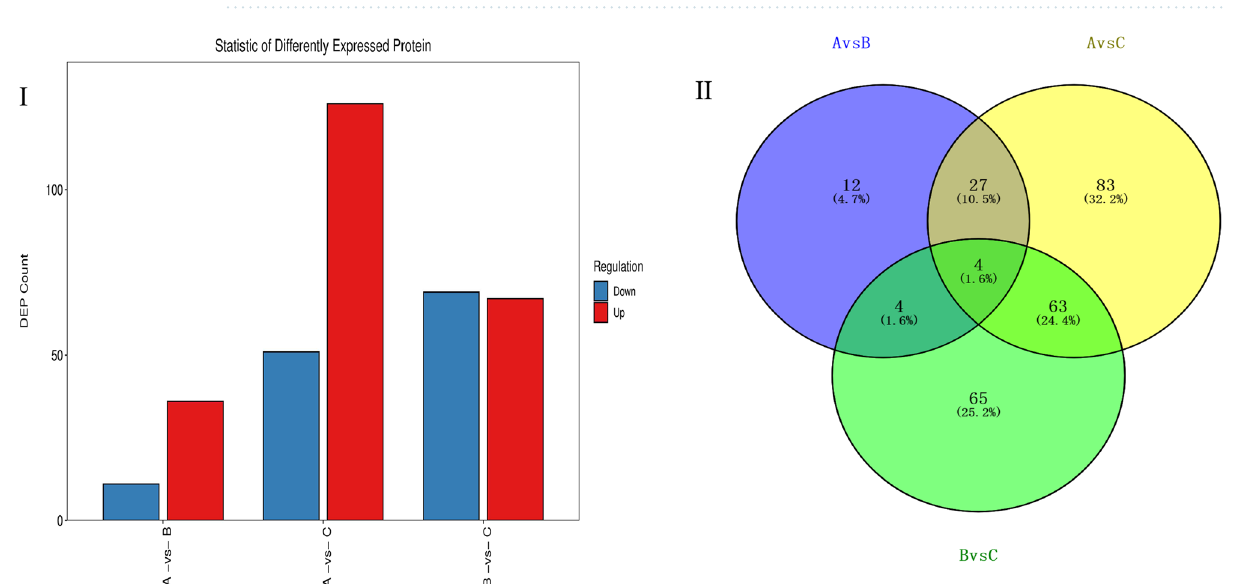
Figure 2. Number of differentially expressed proteins (DEPs) and their Venn diagram analysis. Note : A vs. B denotes B compared with A; likewise, A vs. C denotes C compared with A, and B vs. C is C compared with B. The same for figures